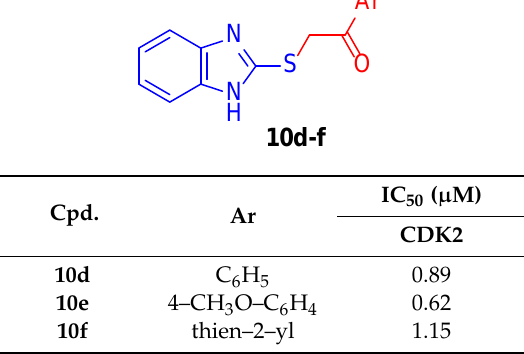
Table 6. IC 50 s for the inhibitory action for benzimidazole derivatives 10d – f against